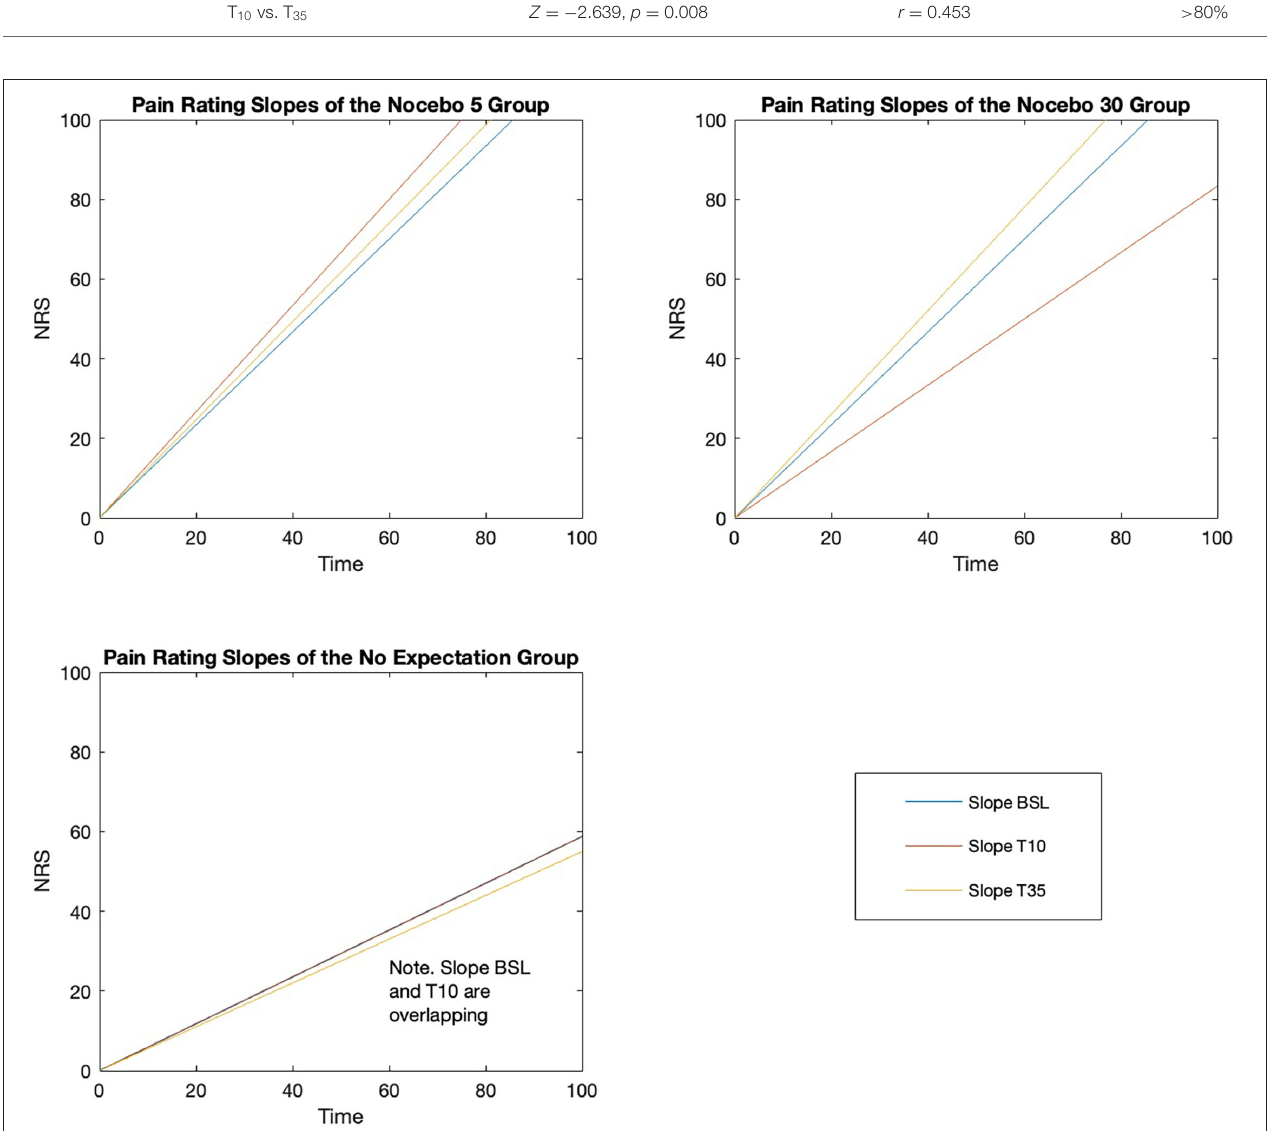
FIGURE 5 | Pain rating slopes for the three groups at the three time-points (Baseline, Test 10, Test 35). 5 min in N5 and after 30 min in N35). Given the